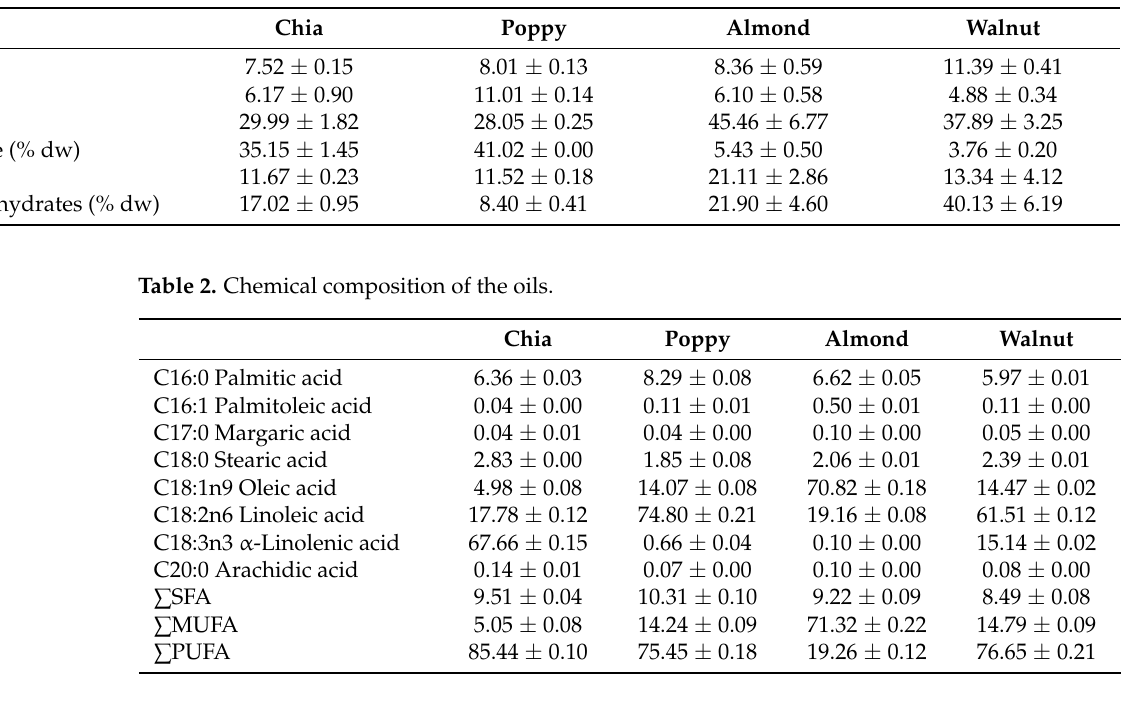
Table 1. Nutritional composition of the flours.